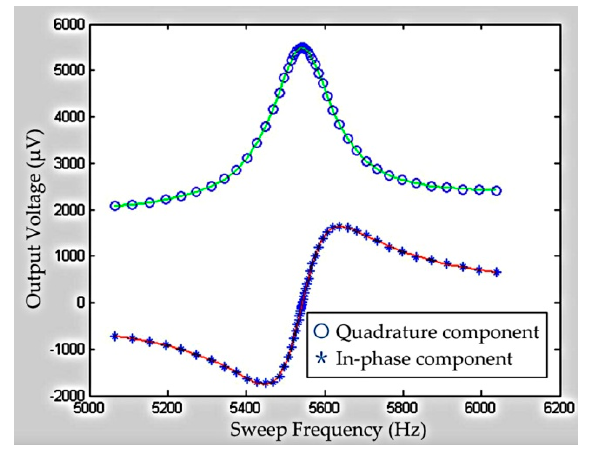
Figure 9. The resonant fitted curves.